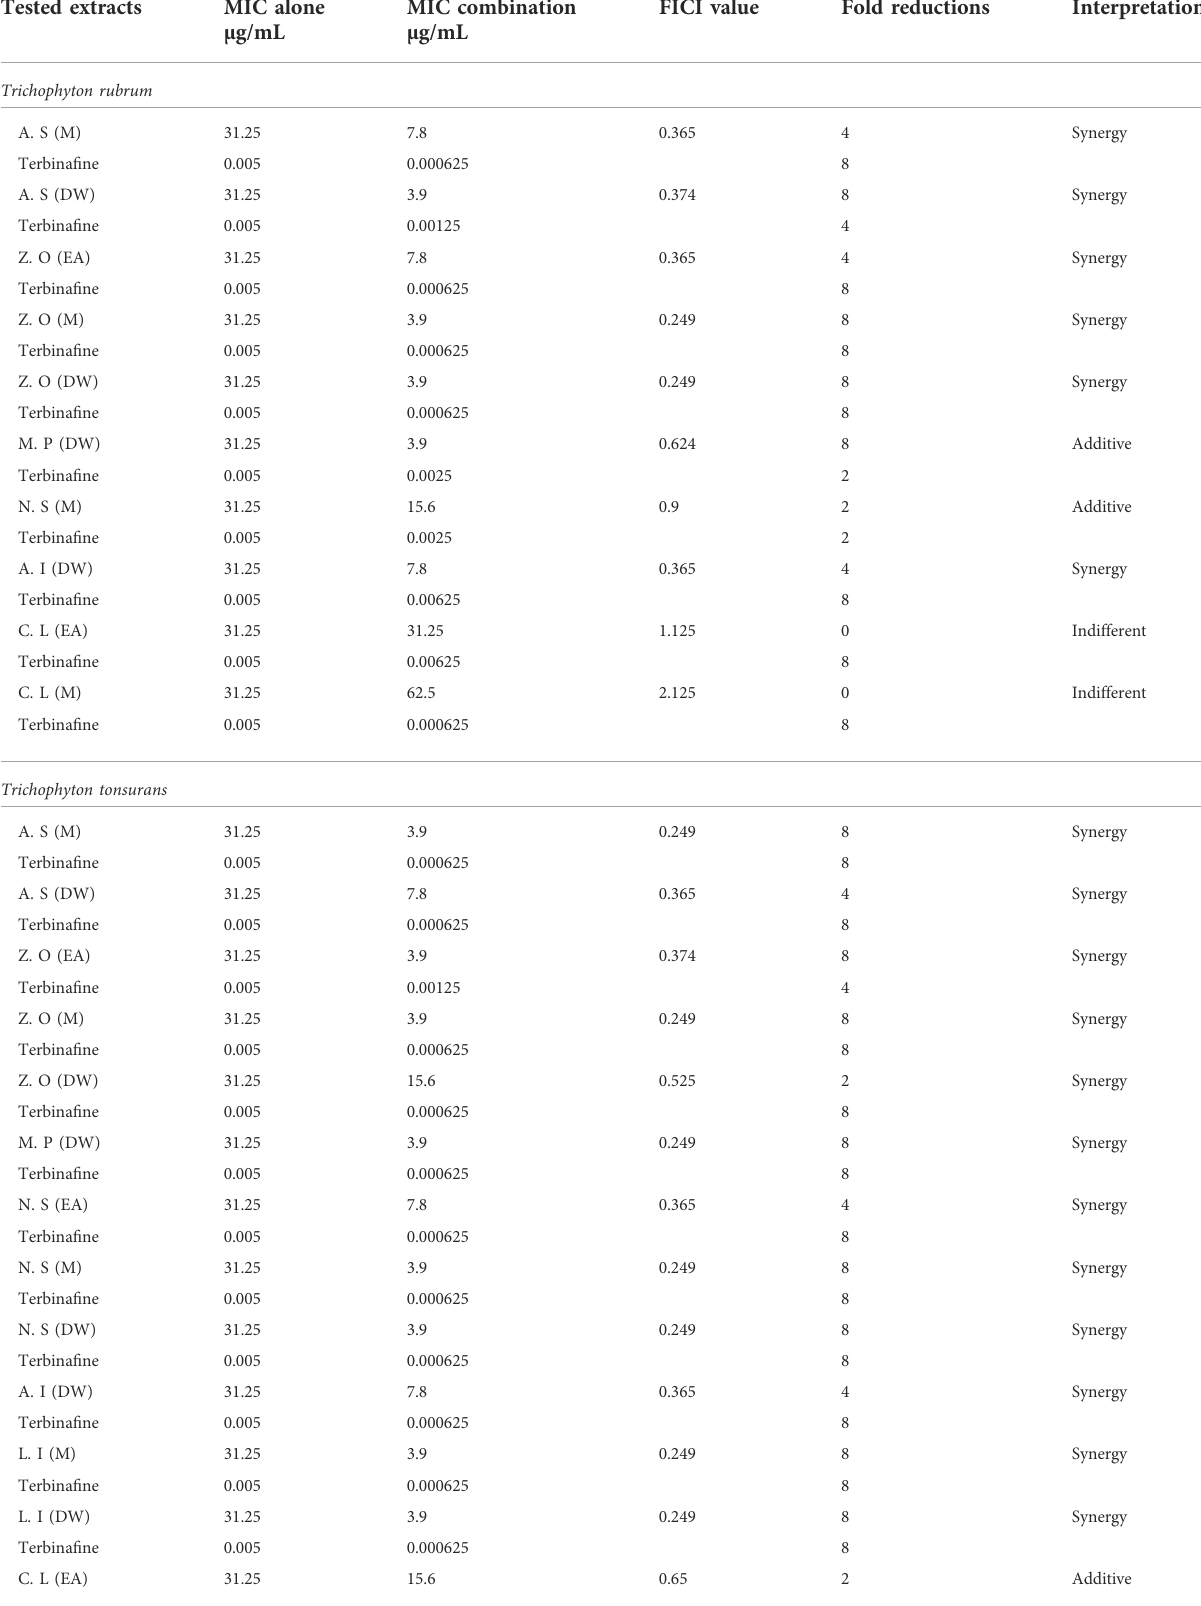
TABLE 6 Representation of synergistic interactions between extracts and antifungal drugs. Tested